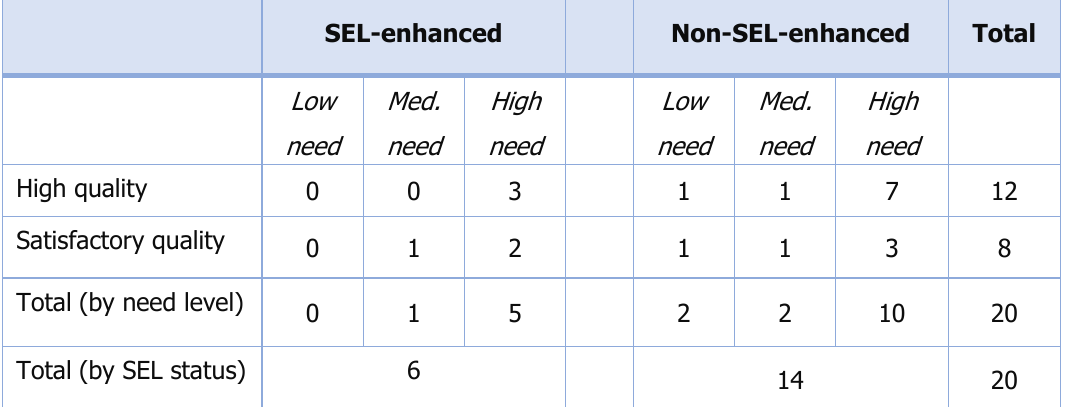
Table 1. Analysis 1: Number of OST Programs by Quality Level, SEL Enhancement Status, and Community Socioeconomic Need SEL-enhanced Non-SEL-enhanced Total